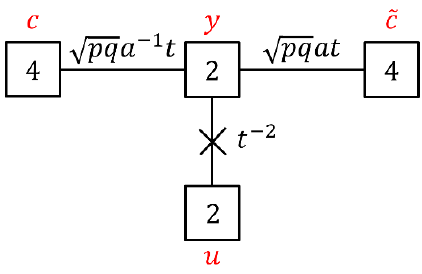
Figure 19 . A quiver of a t-(cid:13)ux tube with (cid:13)ux (cid:0) 1 =